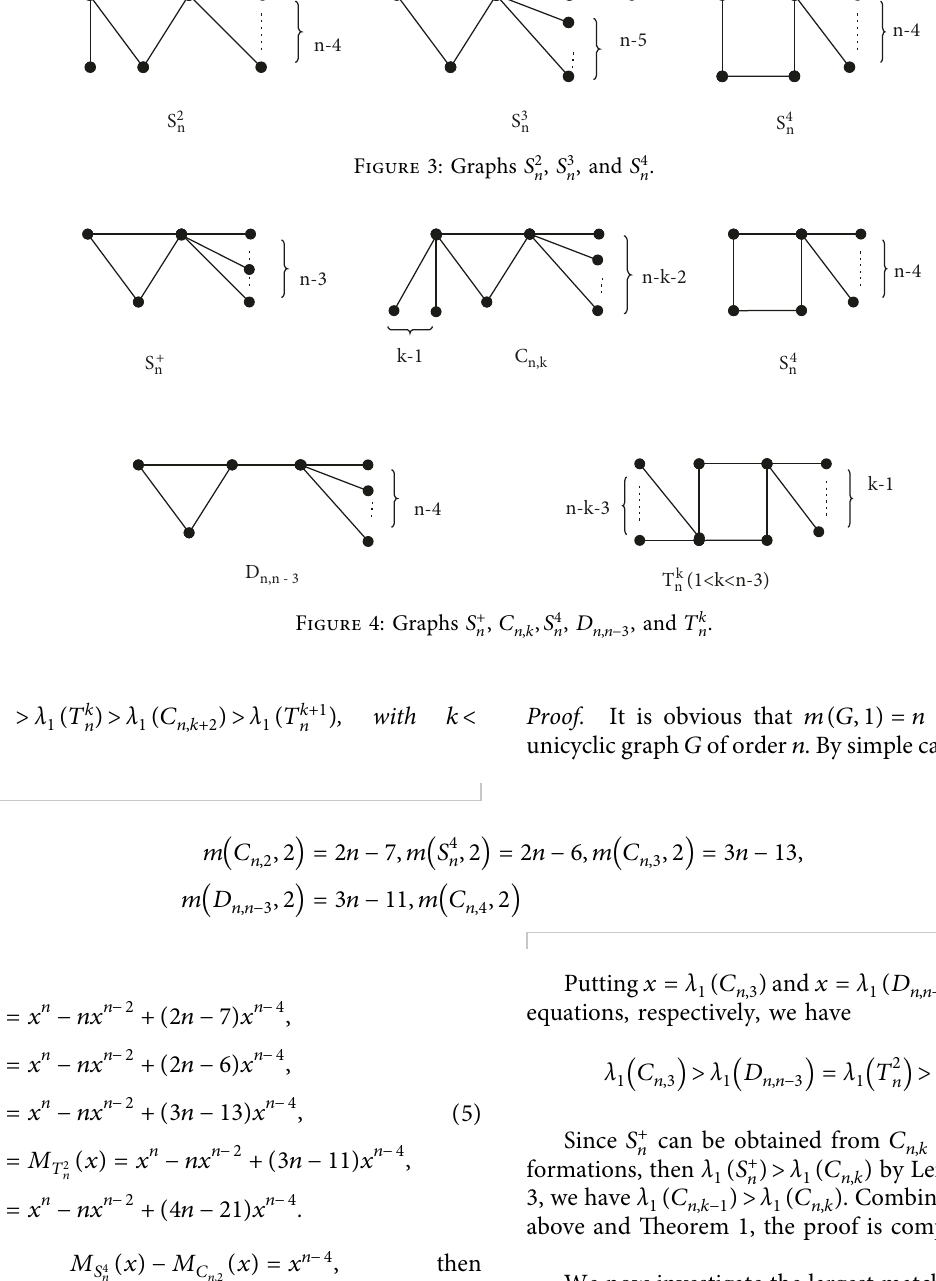
Figure 3: Graphs S 2